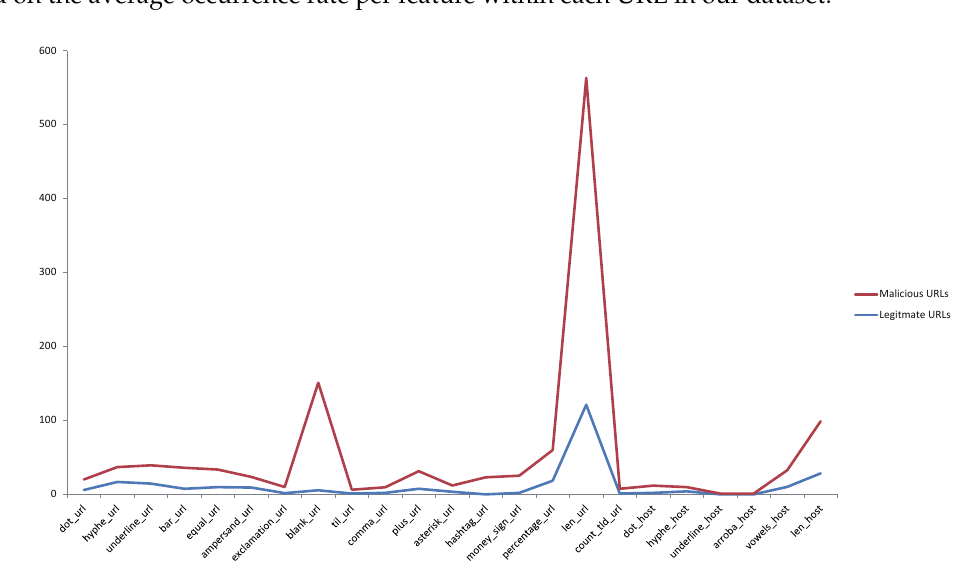
Figure 8. Distribution of URL hand-crafted features in our